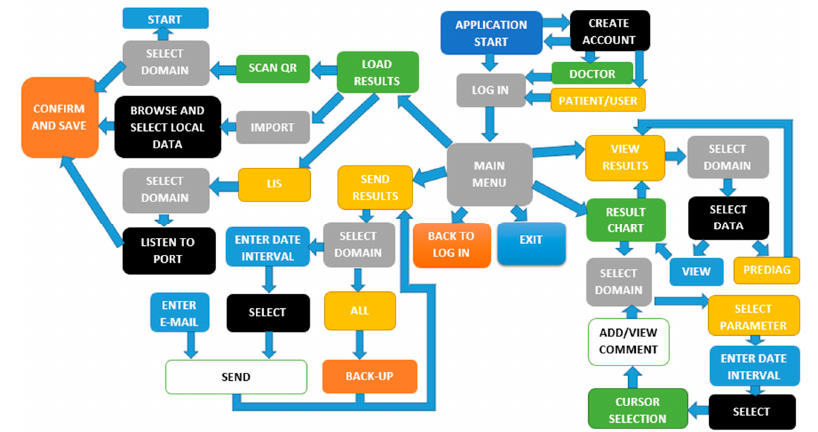
Figure 3. The LabConcept’s organizational chart.